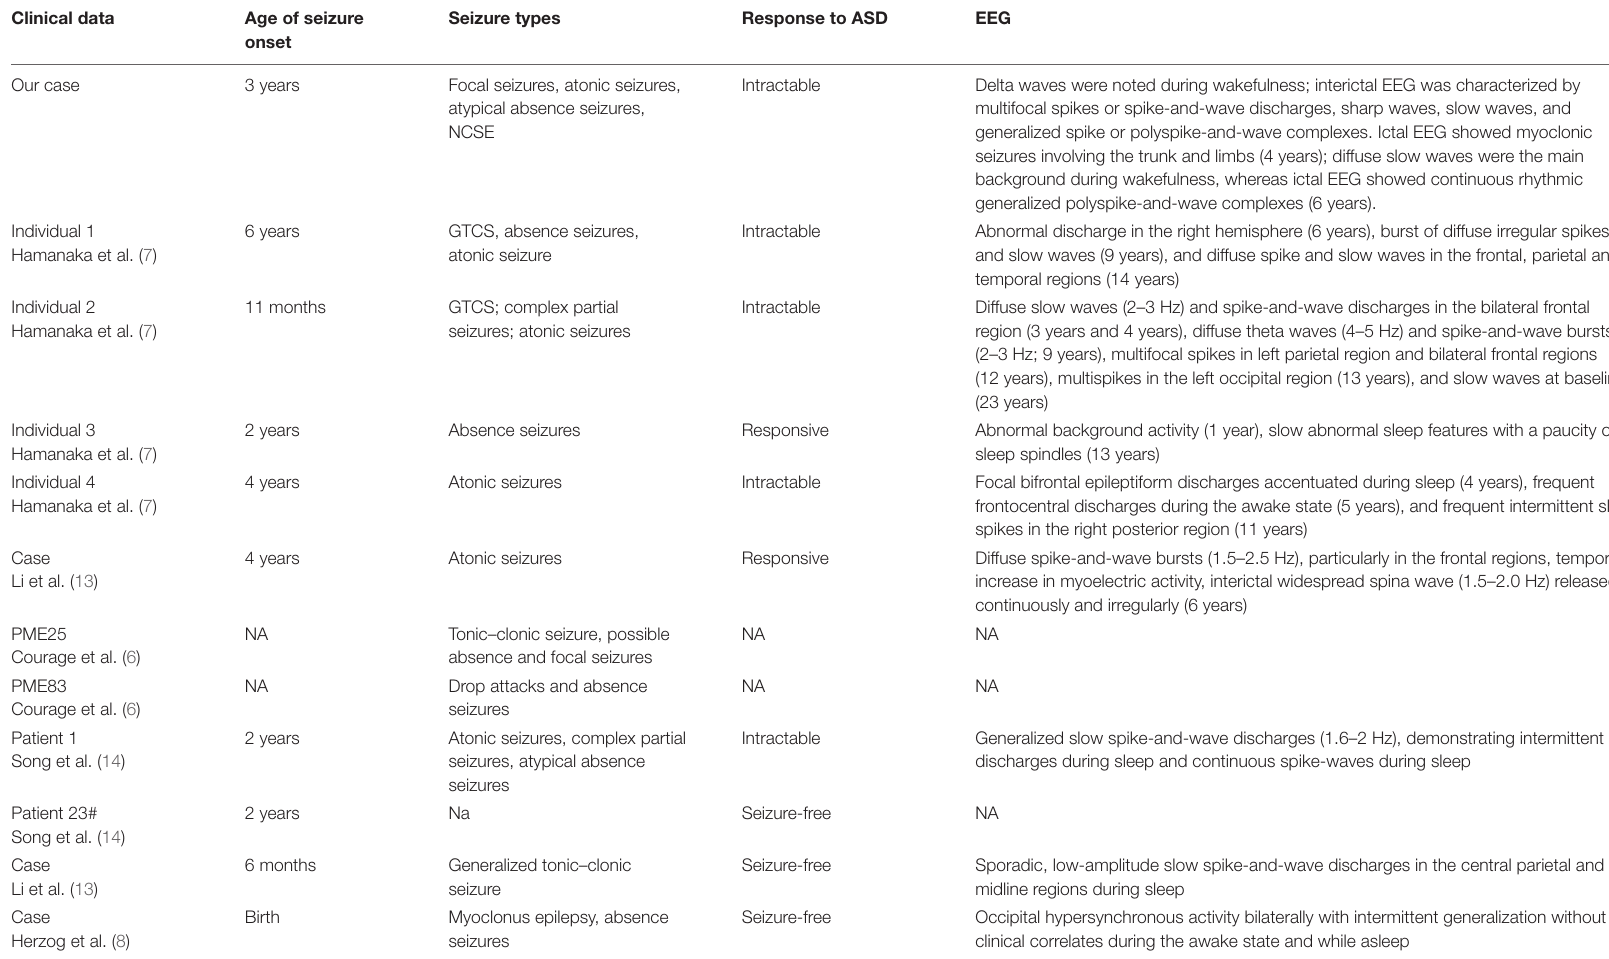
TABLE 2 | Characteristics of epilepsy reported in SEMA6B -related progressive myoclonic